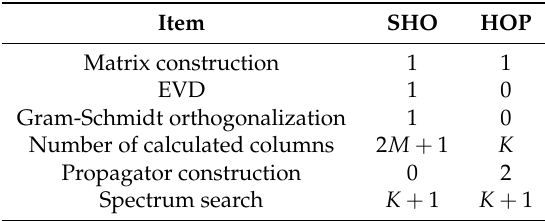
Table 1. Main complexities of different methods. SHO, simplified high-order MUSIC method; HOP, high-order propagator-based method. Item SHO HOP Matrix construction 1 1 EVD 1 0 Gram-Schmidt orthogonalization 1 0 Number of calculated columns 2 M + 1 K Propagator construction 0 2 Spectrum search K + 1 K +